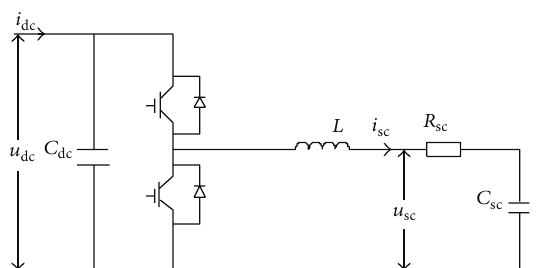
Figure 1: Design of the entire system.